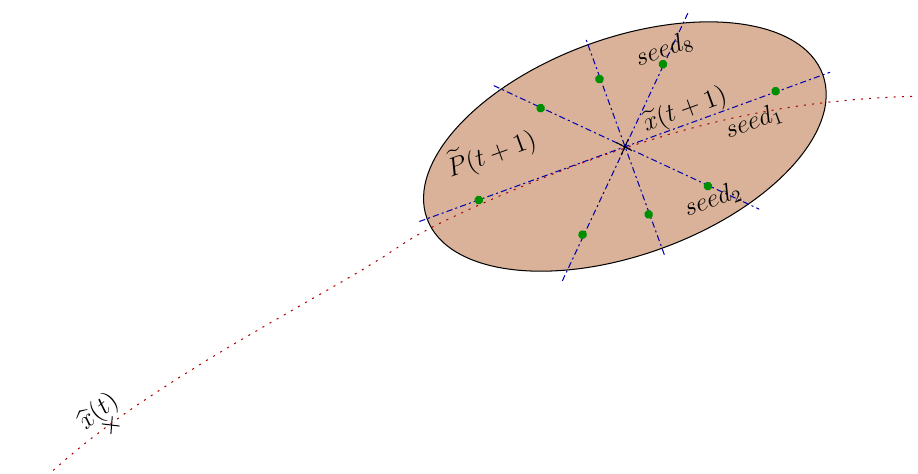
Figure 8. Sharing of Iterative Closest Points (ICP) initial conditions applying the Sigma Point techniques P ( t + 1 ) in the limits marked by (cid:101)